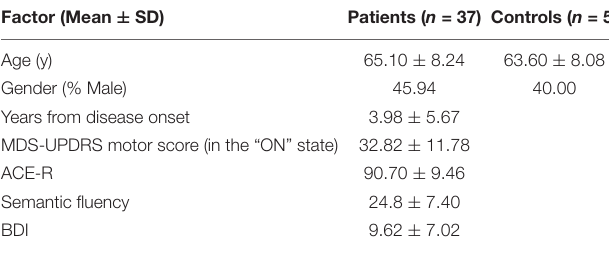
TABLE 1 | Study 2 participant